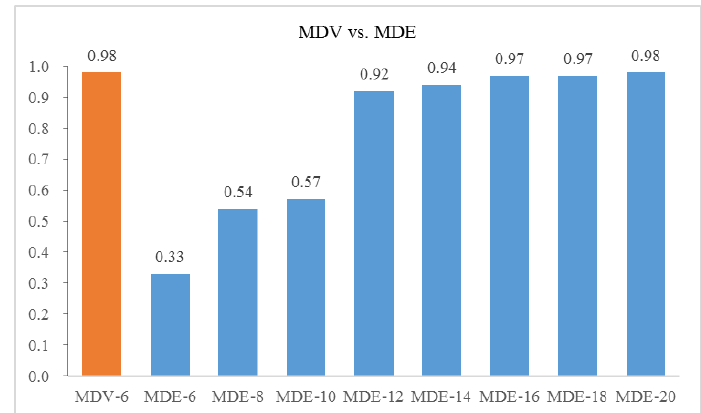
Figure 10. Identification accuracy between MDV and various MDE.